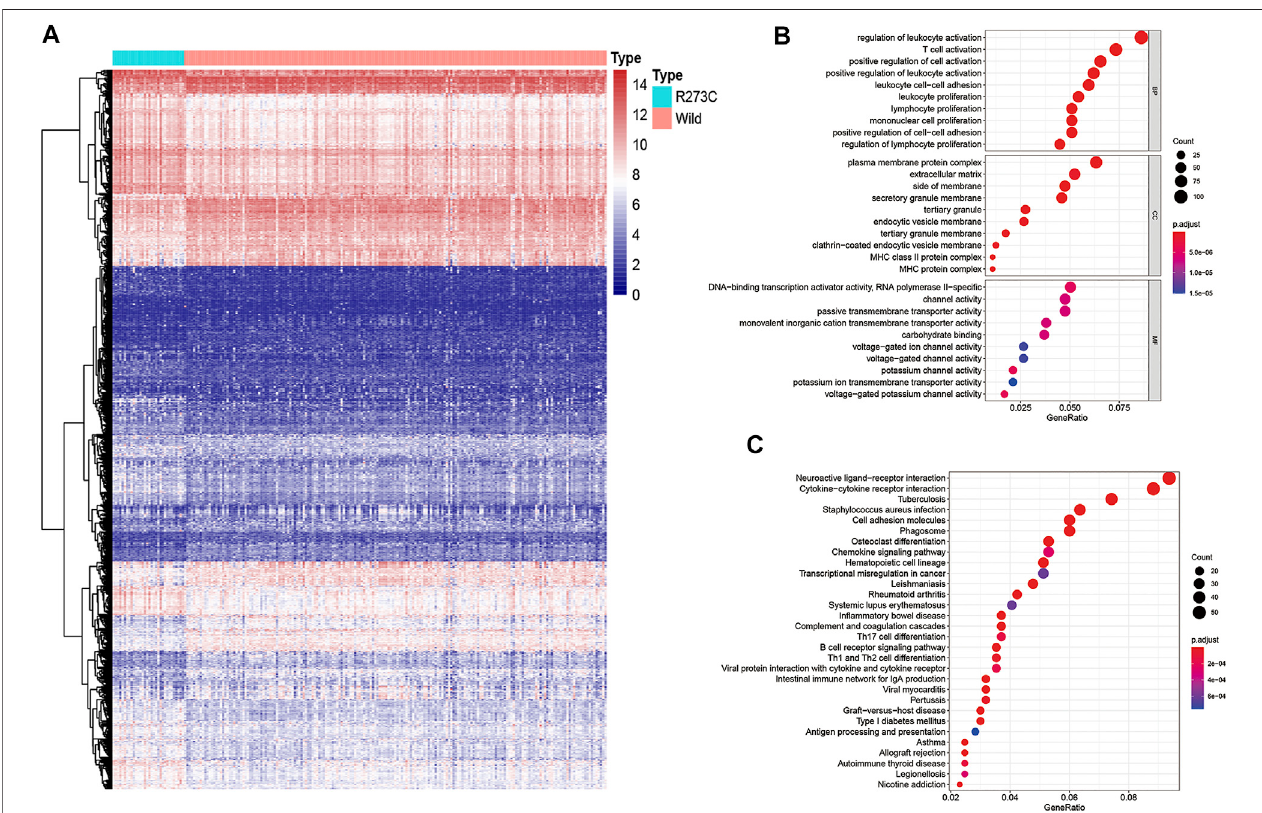
FIGURE 4 | Heatmap and functional annotation of differentially expressed genes. (A) Heatmap of genes showing signi fi cant differential expressions (adjusted p -value < 0.05,|logFC| > 1).Weusedlog2(TMM+1)forlog-scale. (B – C) GO (B) andtheKEGG (C) annotationofthegenesthatweresigni fi cantlydifferentiallyexpressed in both populations.